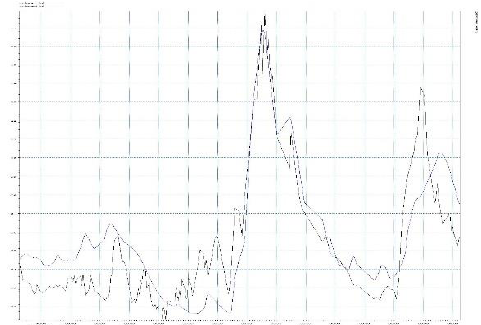
Figure 4. comparison the SWH derived from calibrated numerical model and measurement data for Noshahr Port